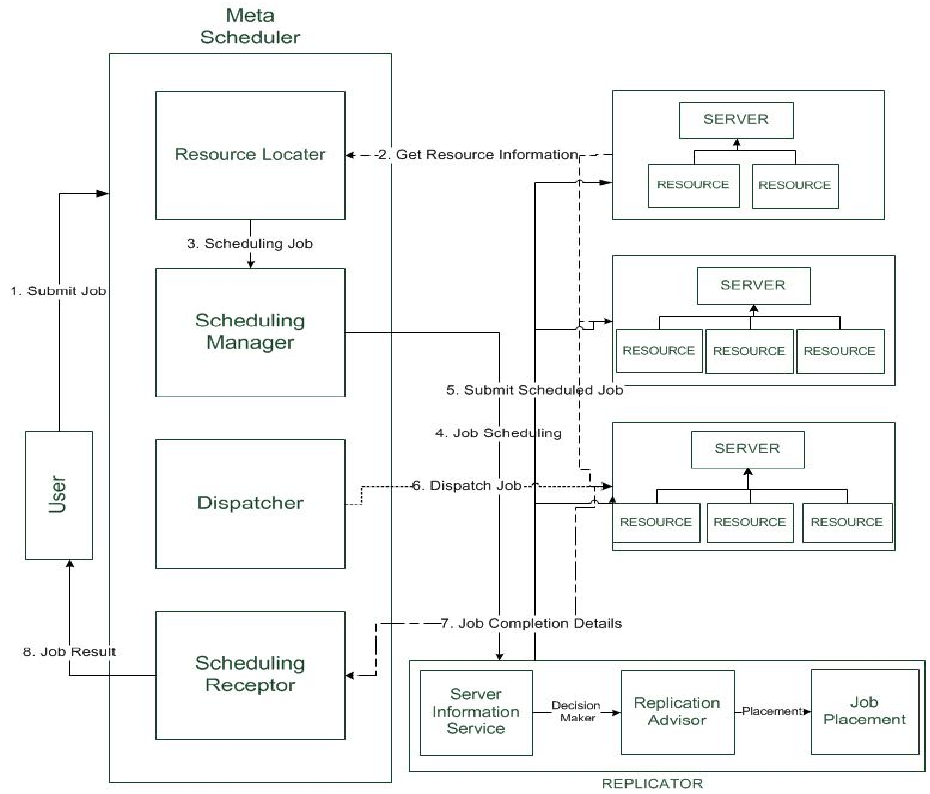
Figure 2. Architecture diagram for centralized dynamic scheduling strategy-replica placement strategies (CDSS-RPS).